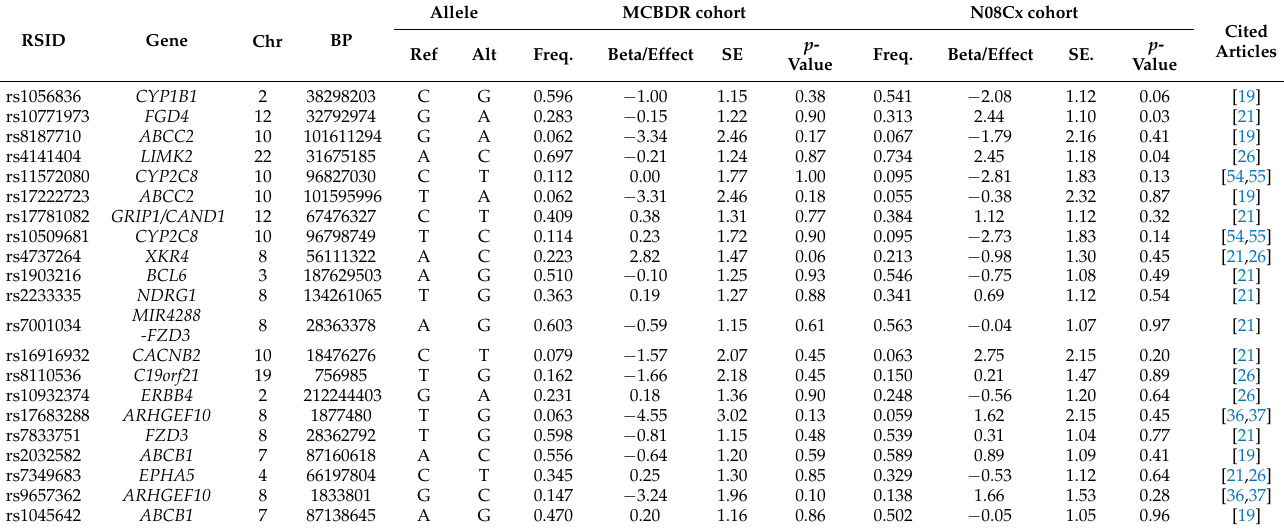
Table 7. Candidate SNPs associated with CIPN from paclitaxel-based treatment in previous studies.